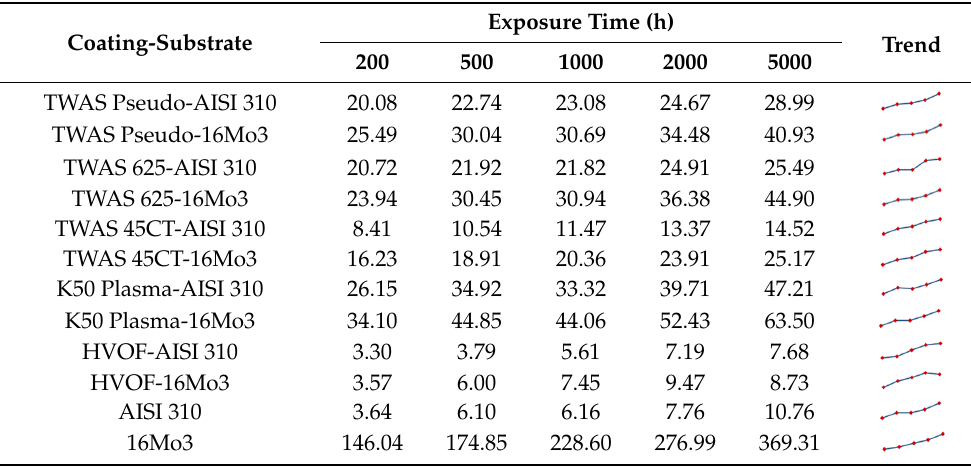
Table 4. Gravimetric results of coatings and materials after exposure at 600 °C in model atmosphere, in g/m 2 .